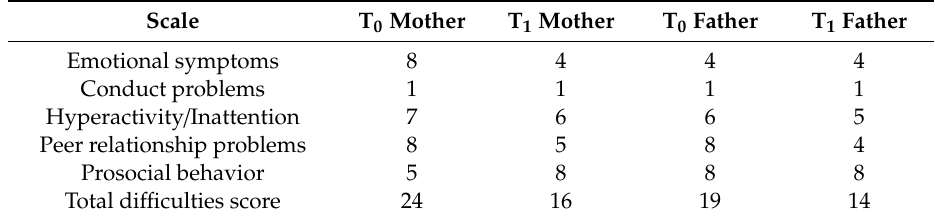
Table 4. Results of the SDQ, administered before and after the equine-assisted therapy. Scale T 0